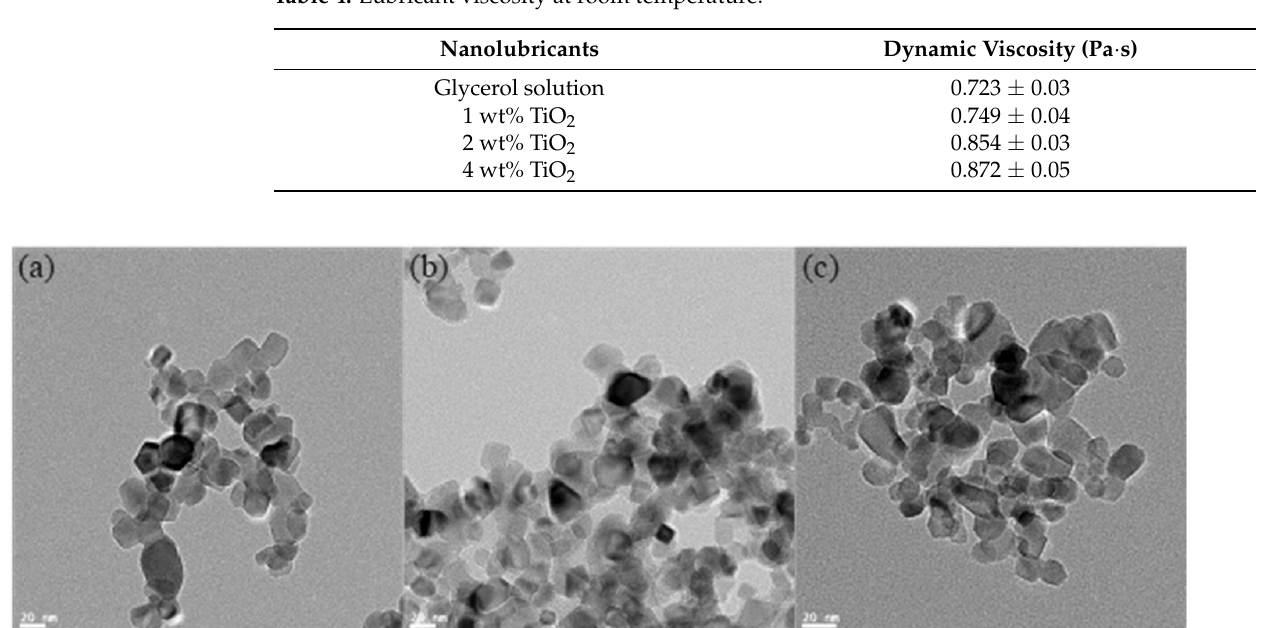
Table 4. Lubricant viscosity at room temperature.